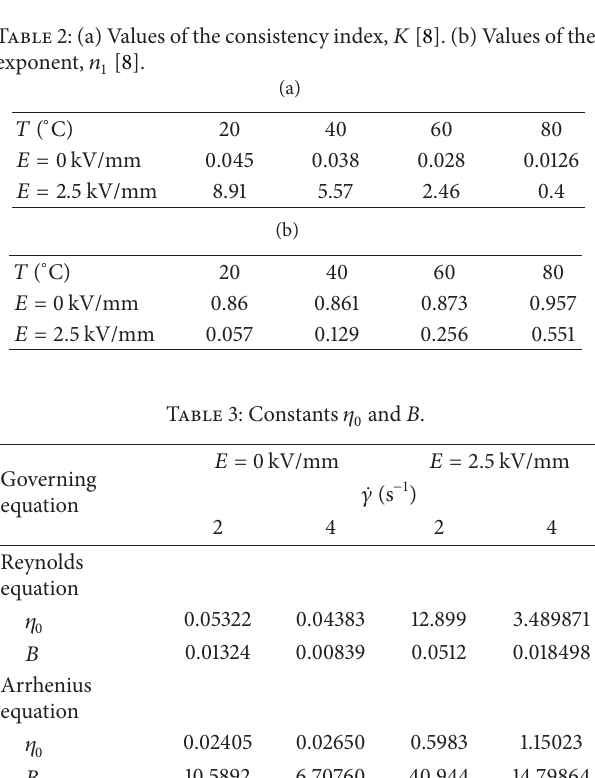
Figure 3 indicates the variation of viscosity with tempera- ture with the applied electric field at 2.5 kV/mm. The viscosity is also found to decrease with the strain rate as indicated by Figures 2 and 3 since the ER Fluid is a shear thinning